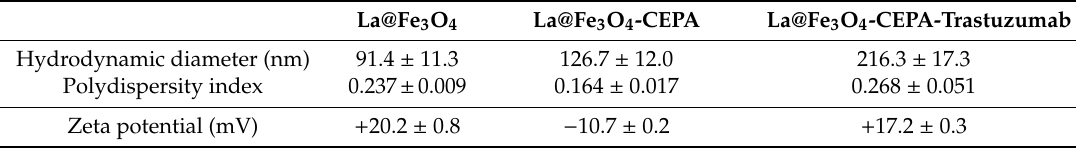
Table 1. The hydrodynamic diameters, polydispersity index (PDI) and zeta ( ζ ) potentials of bare